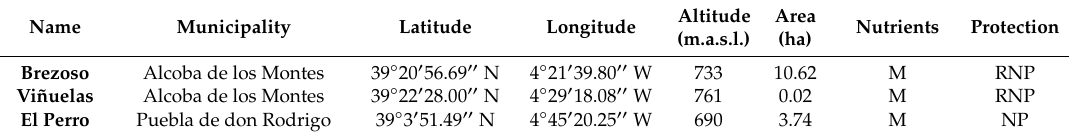
Table 1. Main features of the studied peatlands. Nutrients source: M = minerotrophic. Protection: RNP = reserve national park; NP =